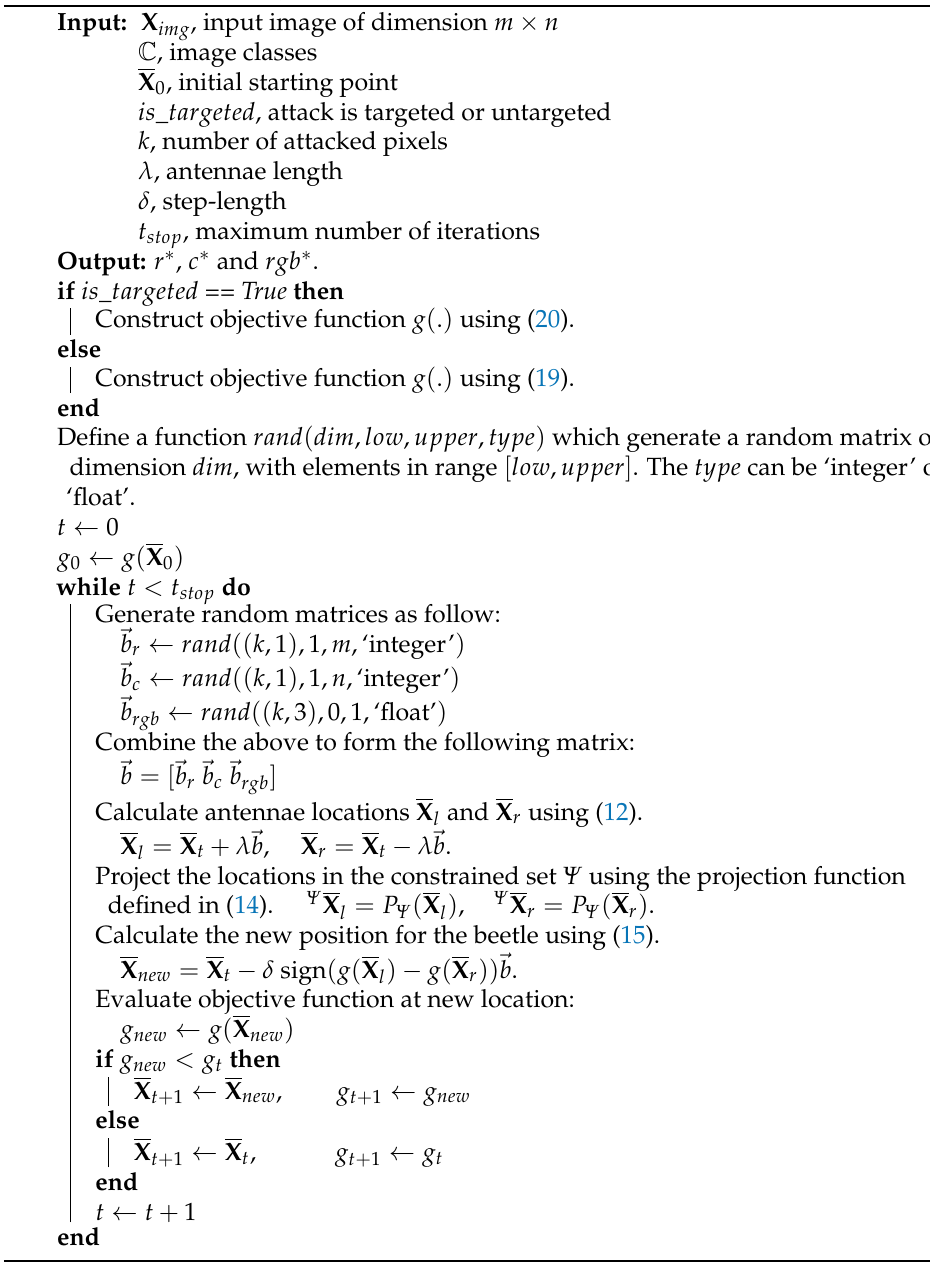
Algorithm 1: Attacking